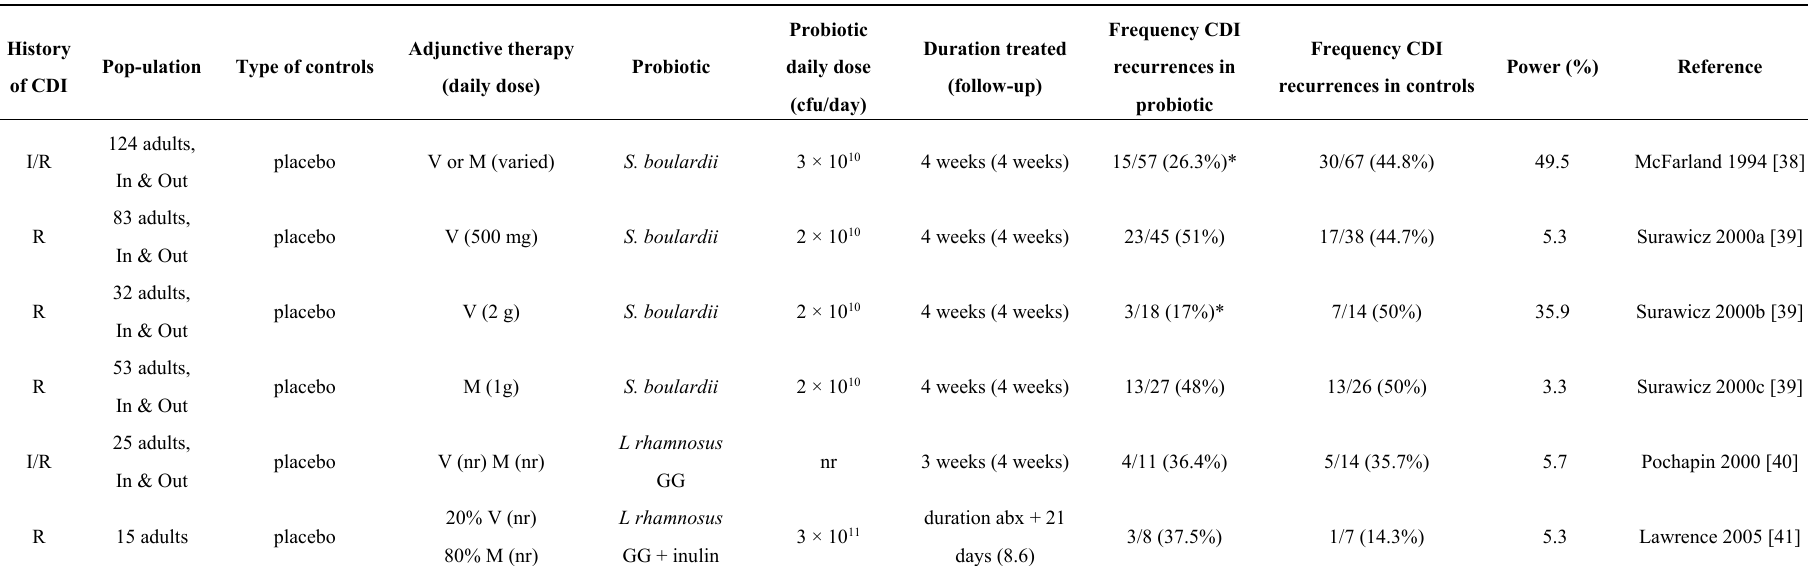
Table 4. Secondary prevention by probiotic type for treatment of Clostridium difficile infections